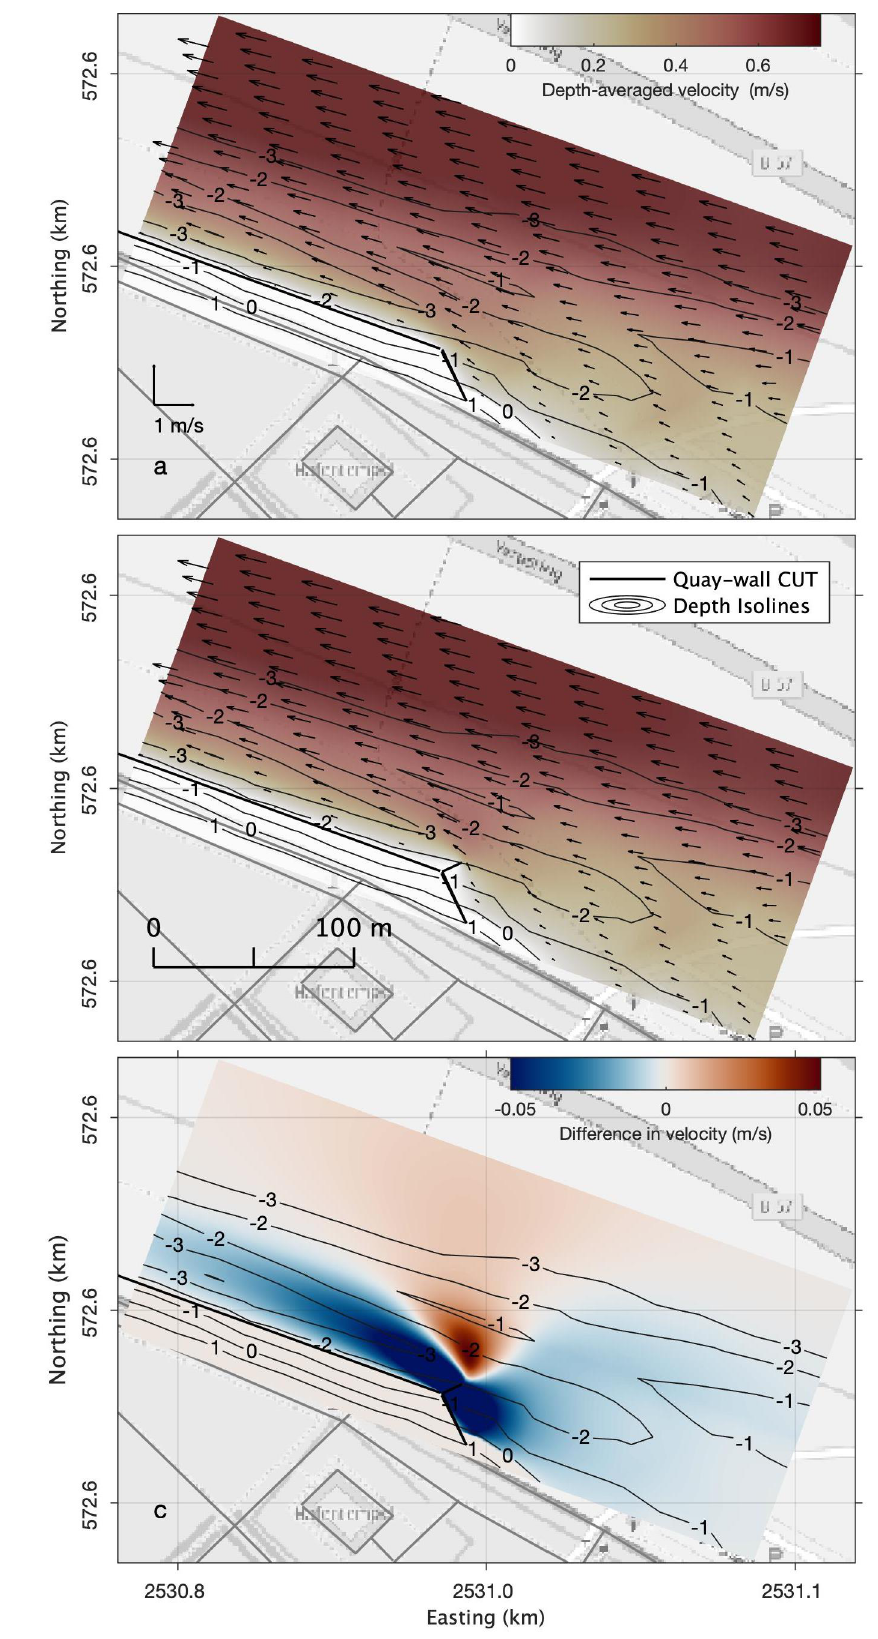
Figure 11. Depth-averaged flow velocity for a case ( a ) without protruding structure and ( b ) including a projecting structure CDW of 10.88m and ( c ) the difference in flow between these two